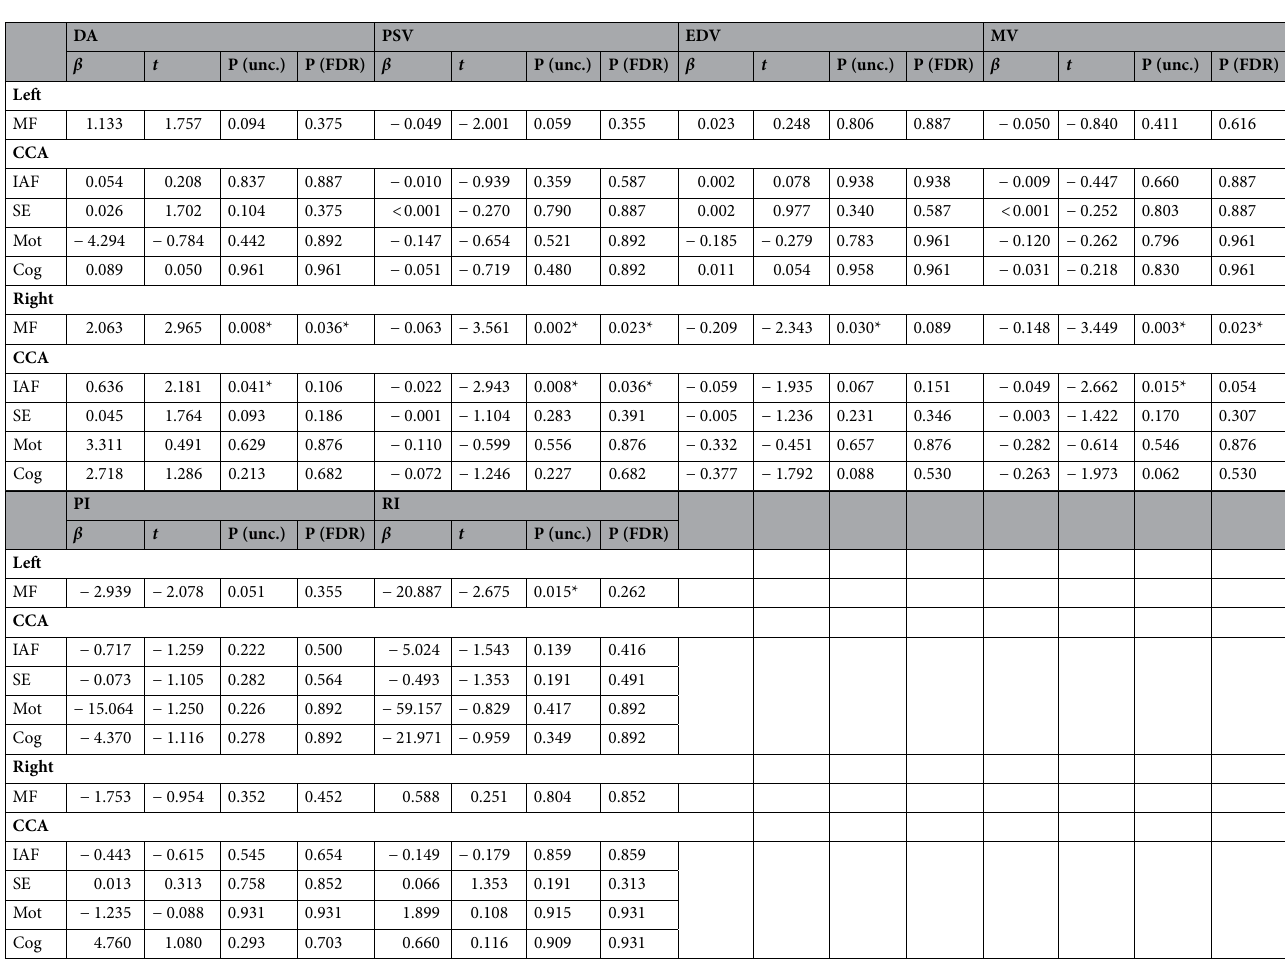
Table 3. Results of LMEM examining the effects of the left ultrasonographic parameters on MEG spectral parameters and FIM. CCA common carotid arteries, Cog . cognitive-FIM score, FIM functional statistics with FDR-correction, P (unc.) uncorrected p values of t test, SE Shannon entropy. β , estimated coefficient of the predictor. t , t -values for testing the null hypothesis that the coefficients are equal to zero. *The terms that make significant contributions to the